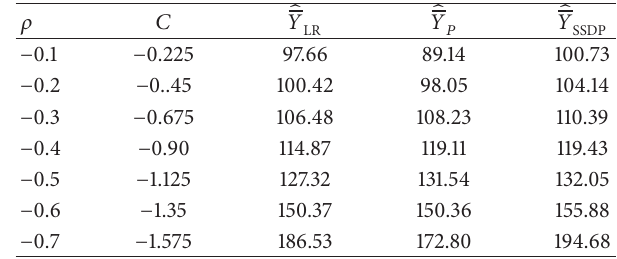
Table 2: Relative efficiencies (in %) of the estimators when 𝑛 = 30 and 𝑅 = 0